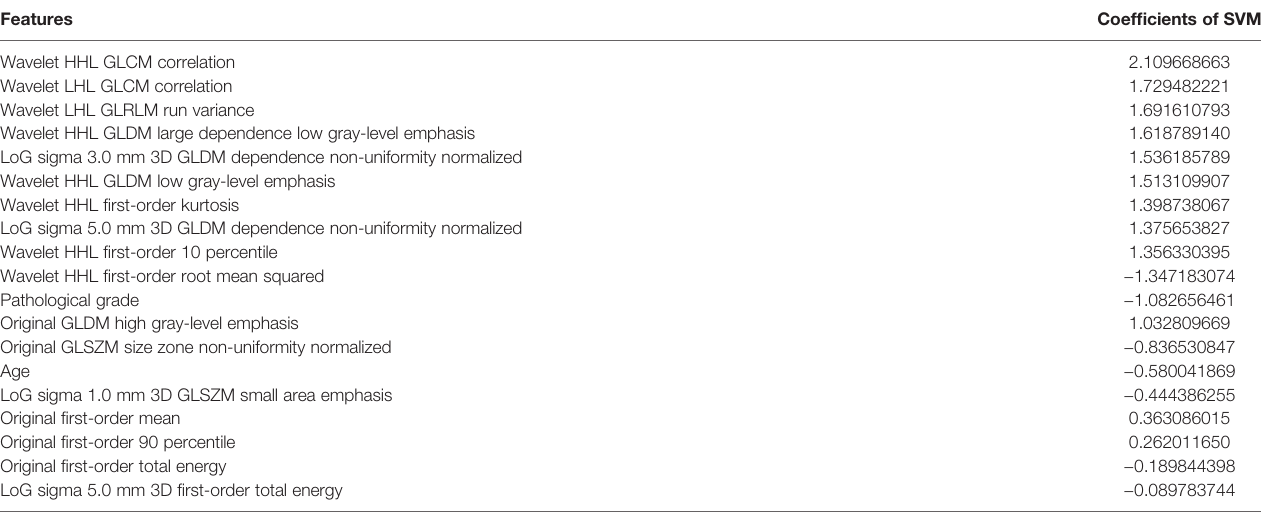
TABLE 3 | Selected features and the coef fi cients of features in the clinical – radiomics model. Features